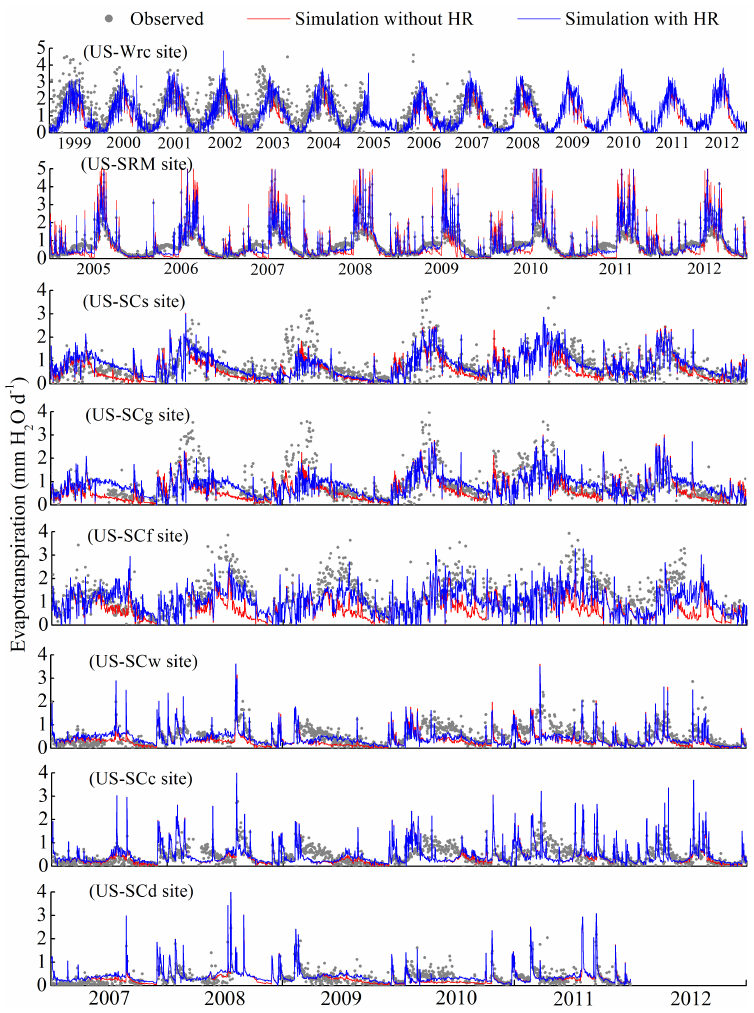
Figure 6. Observed and simulated daily ET at the eight study